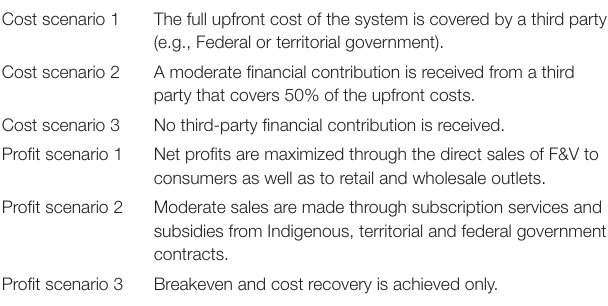
TABLE 1 | Cost and profit